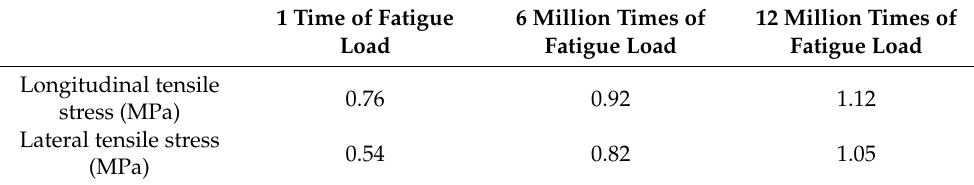
Figure 24. Diagram of calculation of longitudinal tensile stress of base (25 t). Table 8. Maximum Longitudinal Tensile Stress.